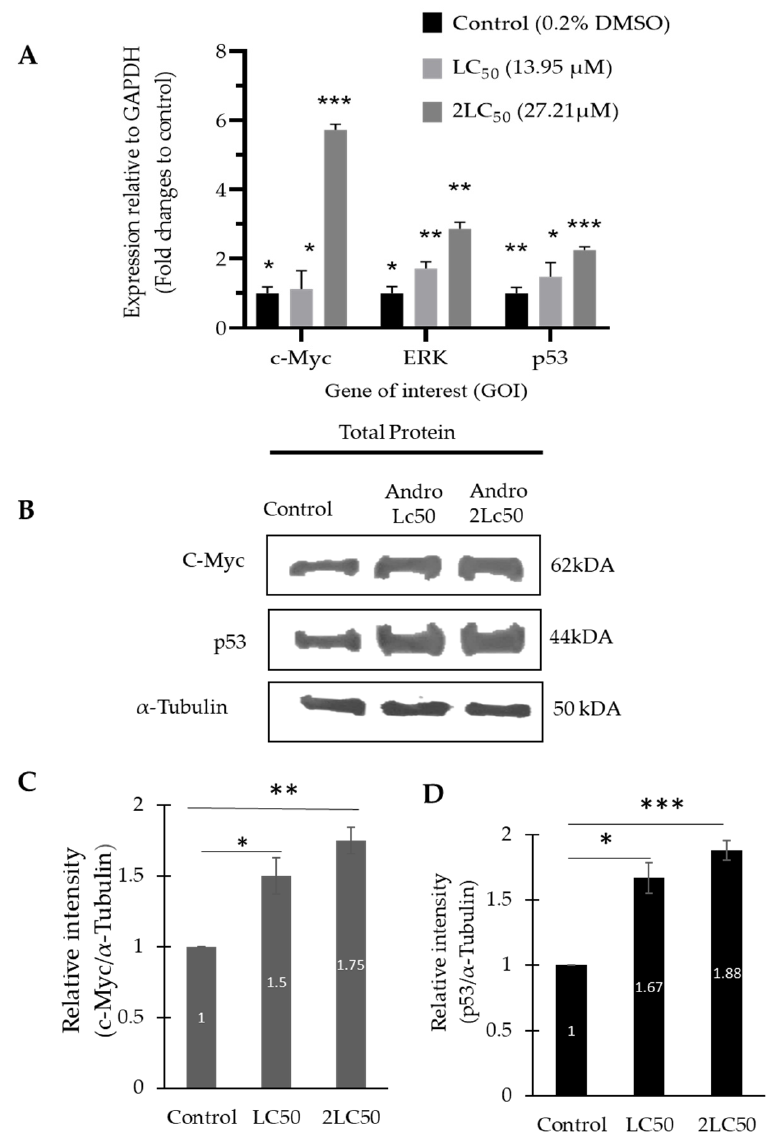
Figure 5. ( A ) Real-Time PCR (qPCR) results expressed relative changes of c-Myc, p53, and ERK over the control, using GAPDH as an endogenous housekeeping gene in DBTRG-05MG. ( B ) Representative Western blot analysis of p53 and c-Myc from DBTRG-05MG total cell lysate. The level of these protein expressions was normalized to α -tubulin. Band intensities were quantified using Image J software. Relative intensities of ( C ) c-Myc and ( D ) p53 are presented in the bar graph. Data expressed as mean ± SEM and statistical analysis between three independent groups was performed by t-test compared with the control group: * p < 0.05, ** p < 0.005, *** p < 0.0005.